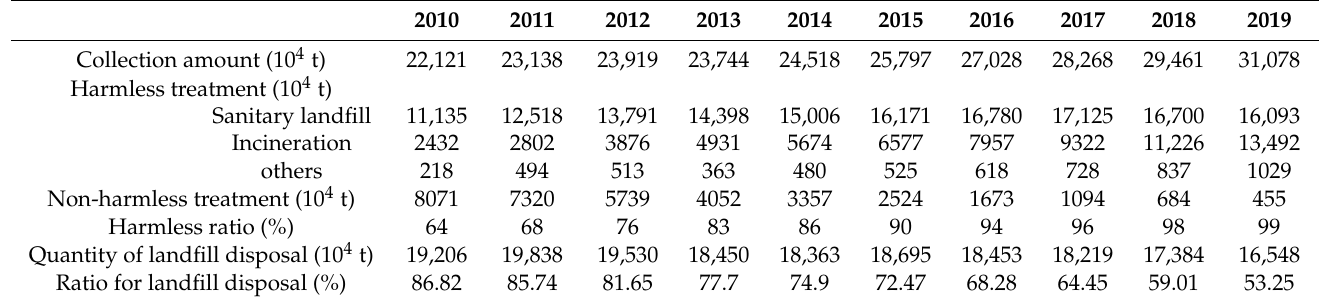
Table 1. Urban and rural solid waste treatment and disposal options in China.